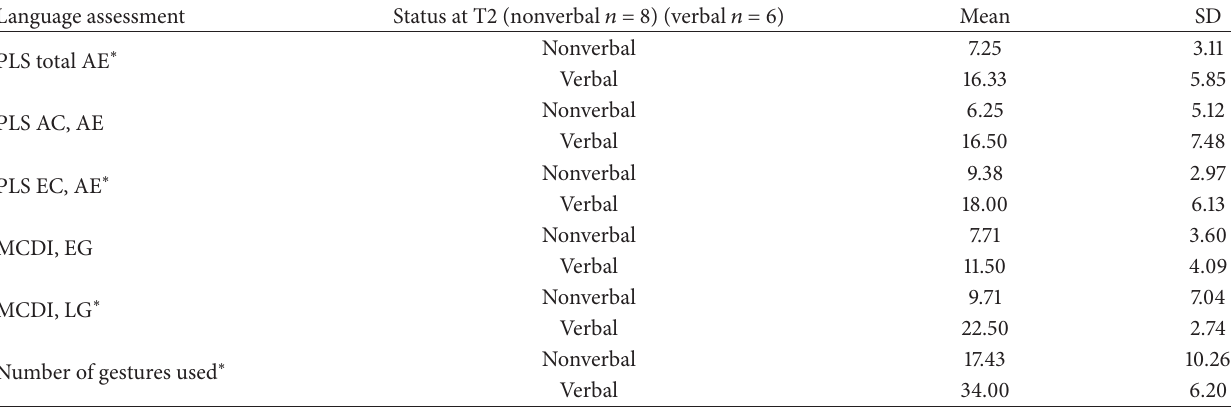
Table 2: Language assessment means and standard deviations for the longitudinal sample at study initiation. Language